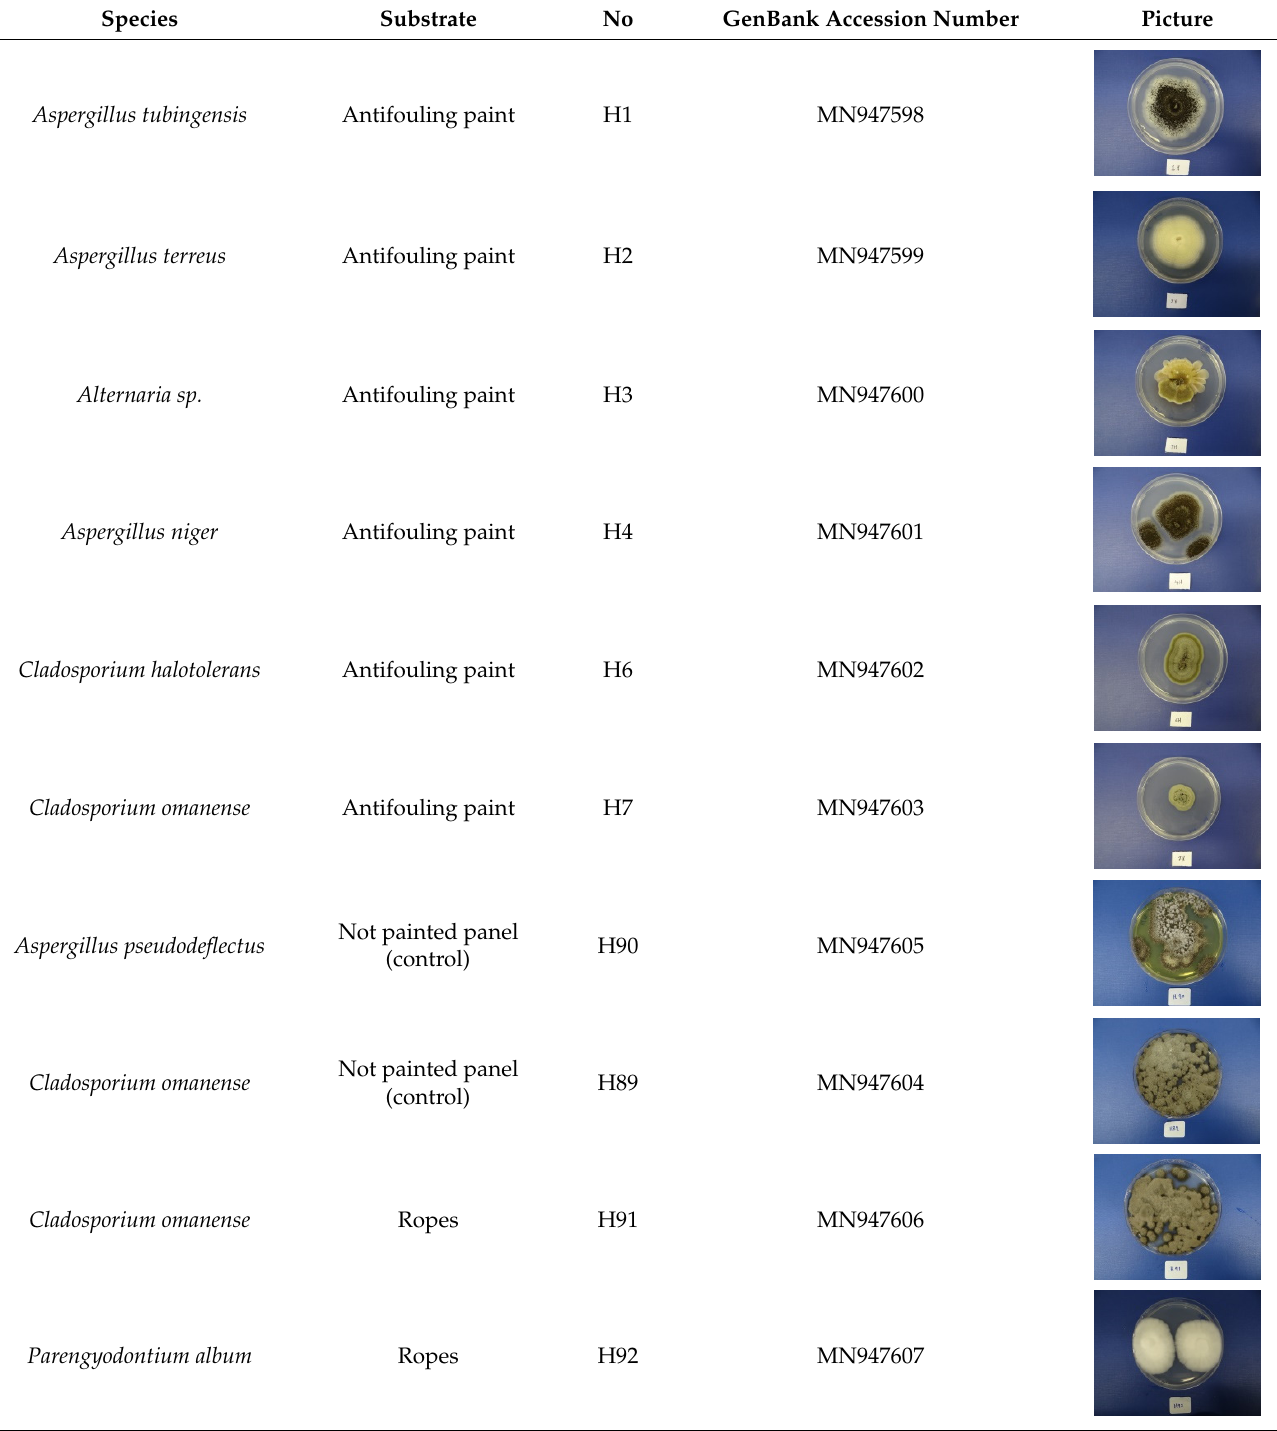
Table 1. The list of fungal isolates from panels painted with the antifouling paint and not painted (control) panels and ropes.